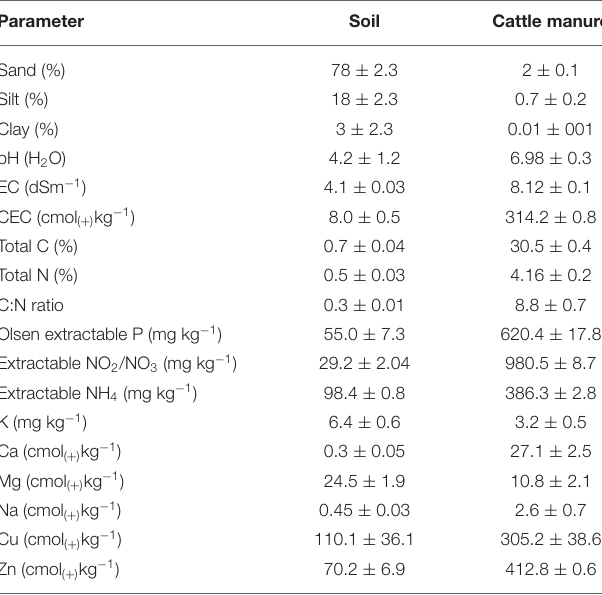
TABLE 3 | Estimated parameters and intraspecific competitive stress for sorghum and cowpea in monoculture. Parameter